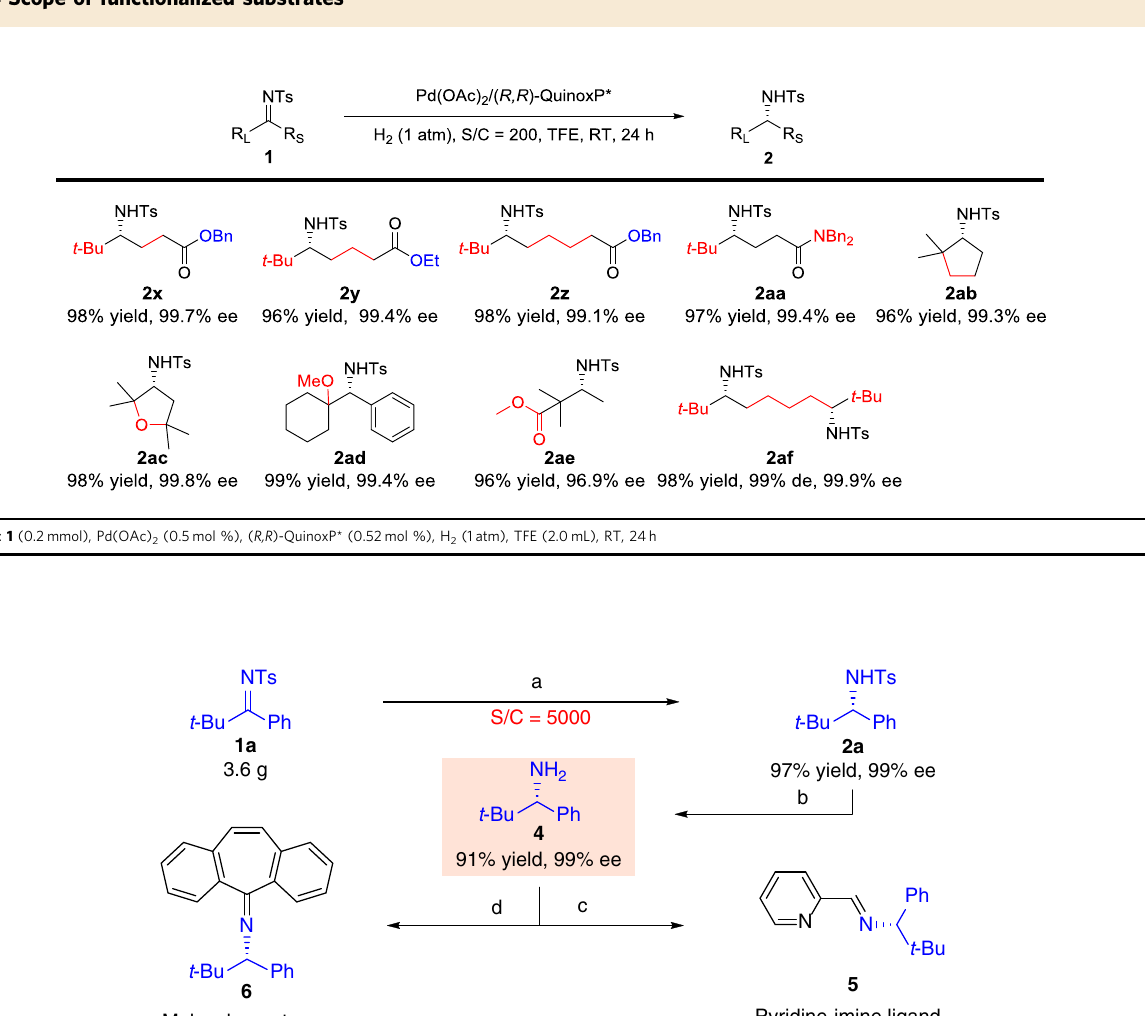
Table 4 Scope of functionalized substrates a